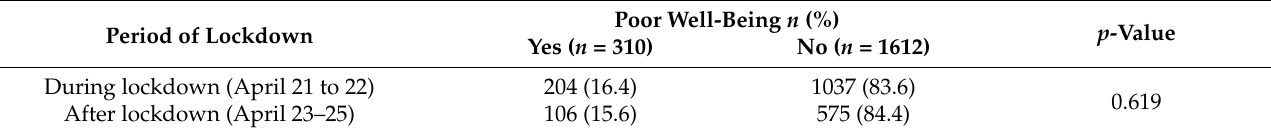
Table 9. Distribution of poor well-being by the period of lockdown ( n =